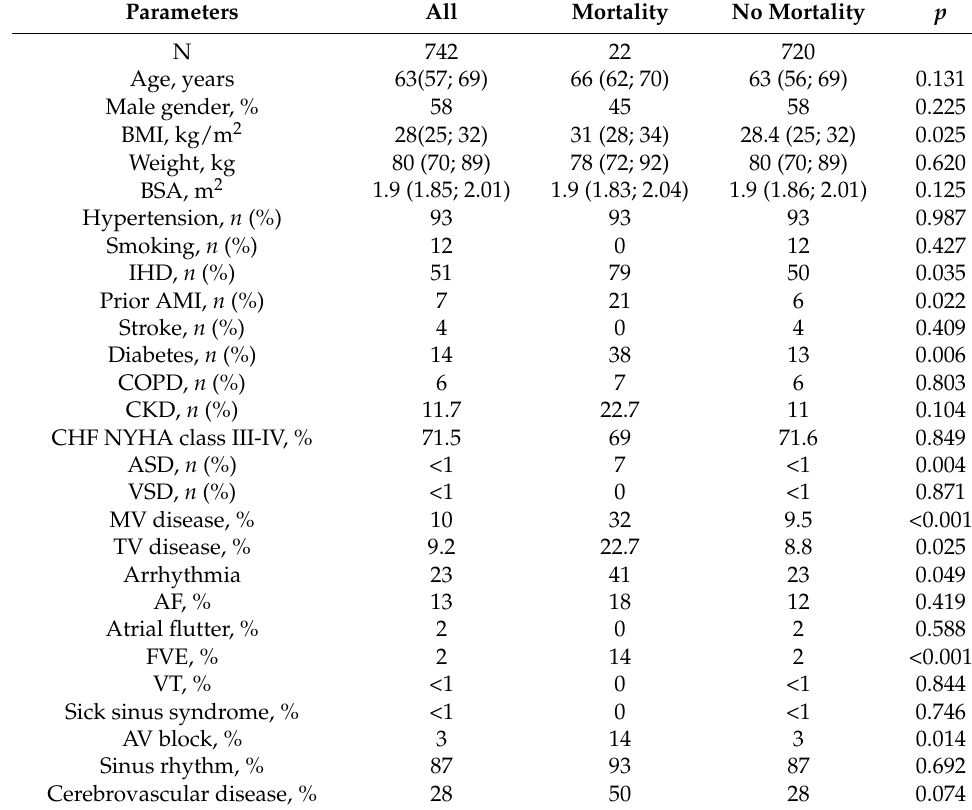
Table 1. Clinical parameters of